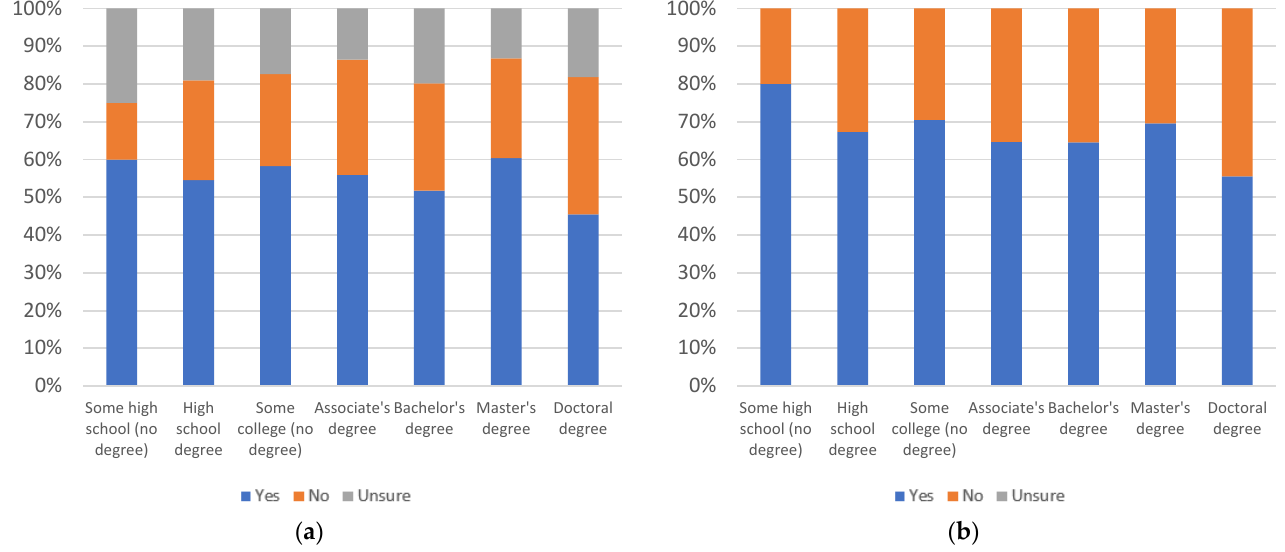
Figure 50. Label trustworthiness judging use, by education level: ( a ) with uncertain respondents (left) and ( b ) without uncertain respondents (right).